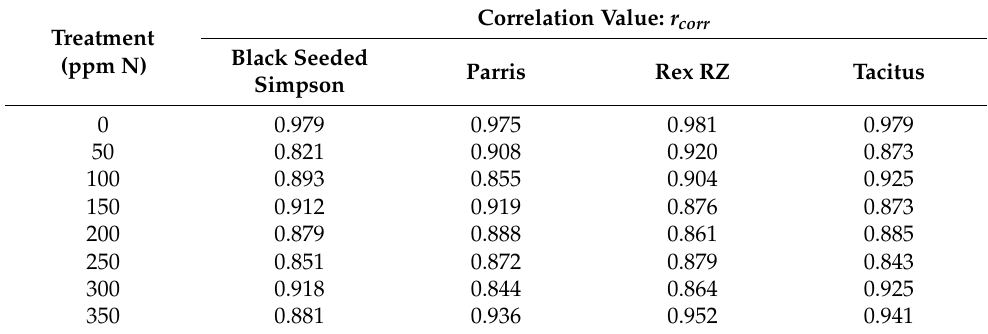
Table 4. Cross-correlation analysis of HSI data of lettuce leaves and applied N concentration solutions. Correlation Value: r corr Treatment Black Seeded (ppm N) Parris Rex RZ Tacitus Simpson 0 0.979 0.975 0.981 0.979 50 0.821 0.908 0.920 0.873 100 0.893